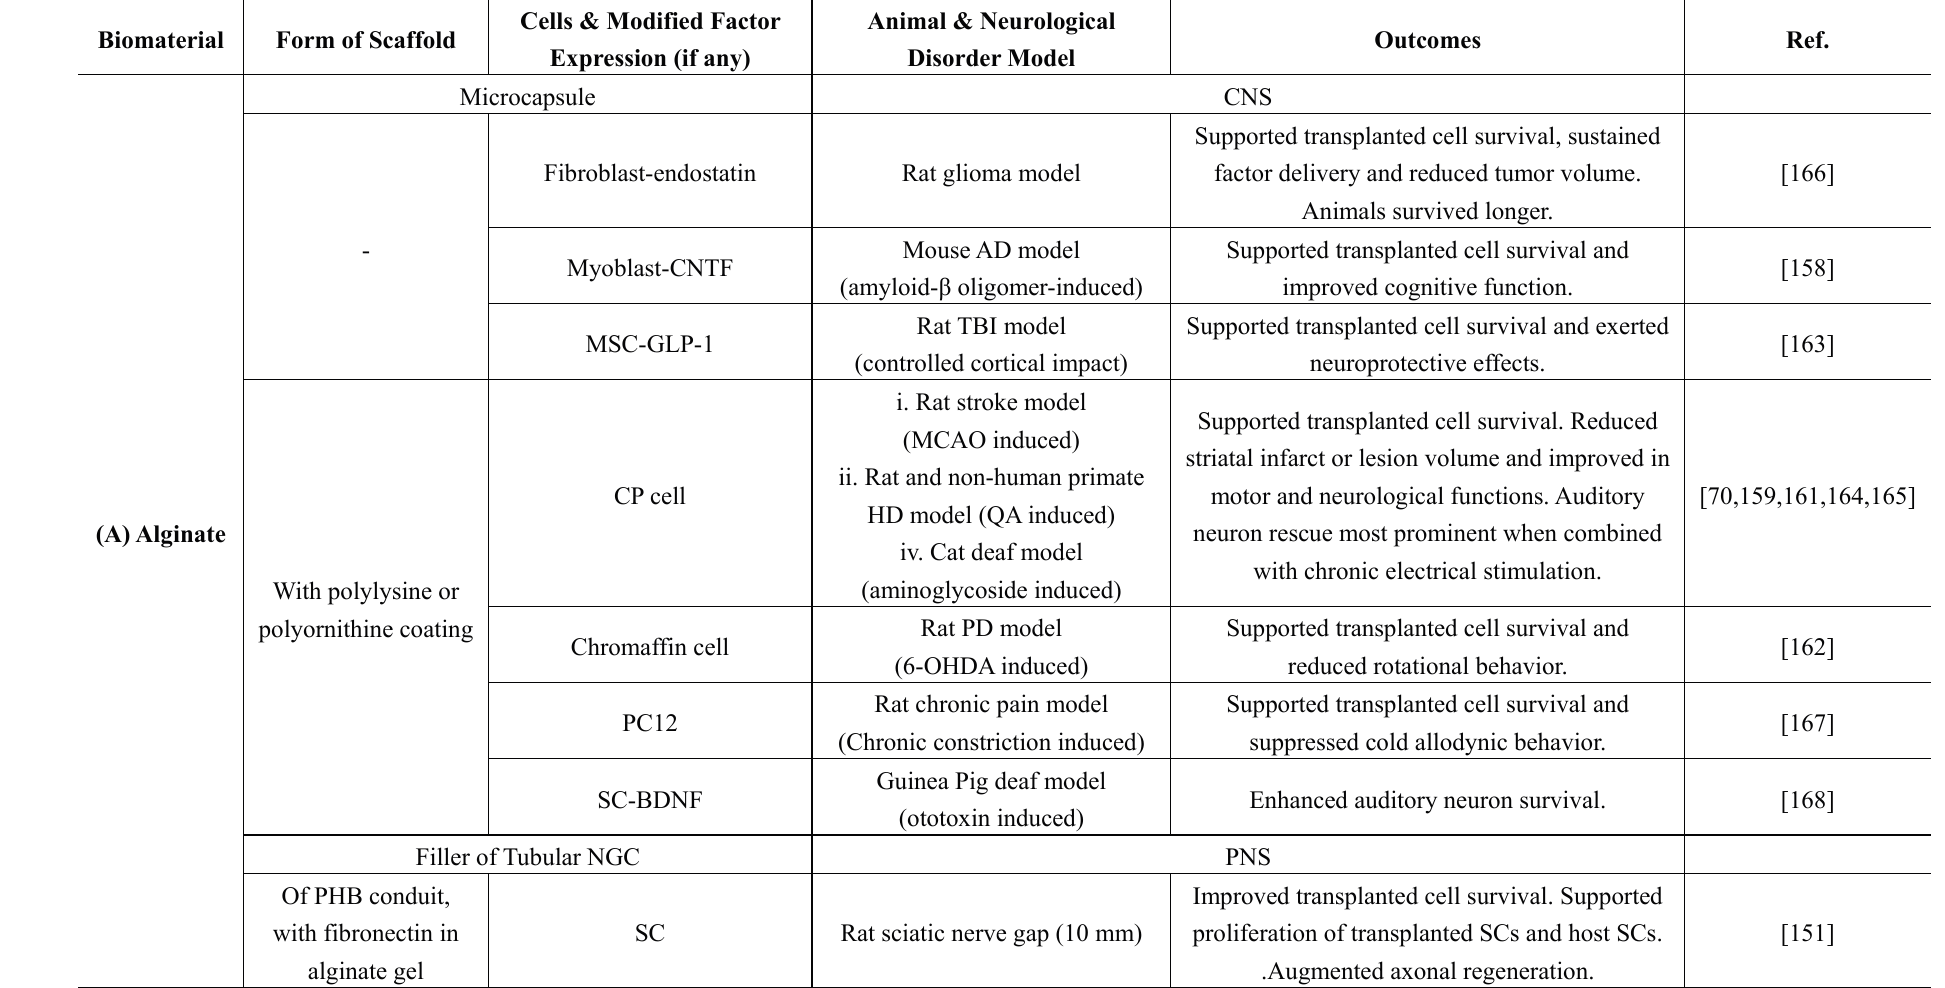
Table 4. Examples of non-animal derived natural biomaterials as cell-carriers applied in animal or clinical trials.